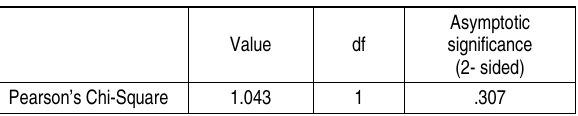
Table 1. Demographic characteristics of respondents